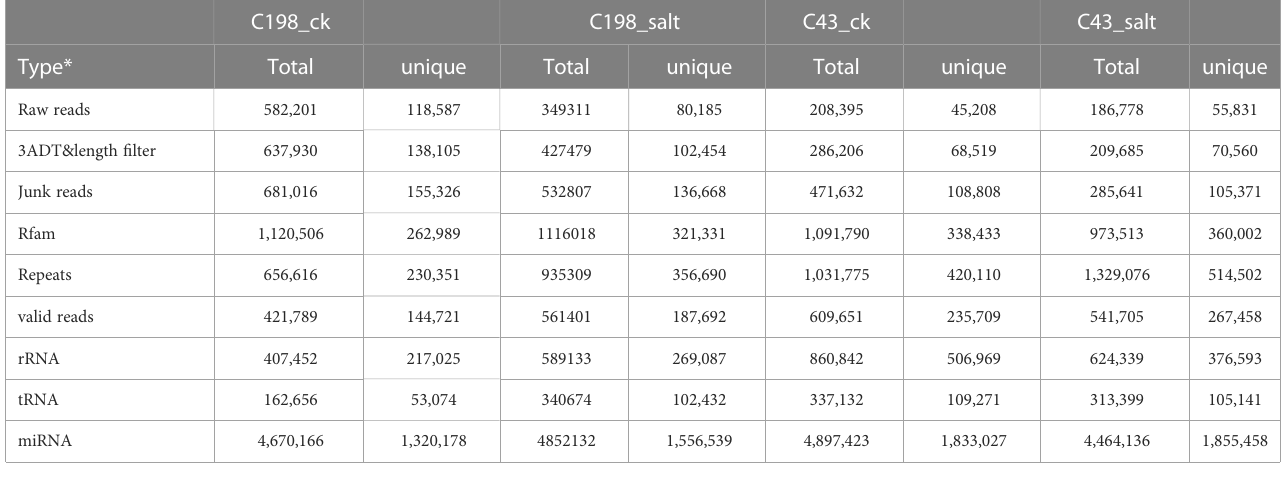
TABLE 1 Small RNA reads from sequencing of four bermudagrass libraries.